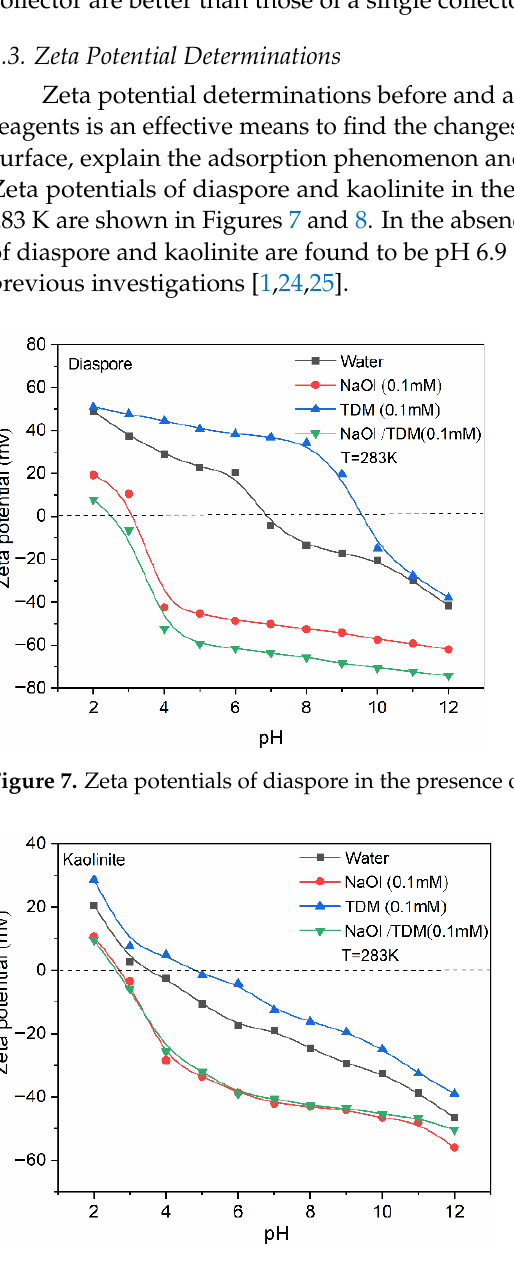
Figure 8. Zeta potentials of kaolinite in the presence of various flotation reagents at 283 K.